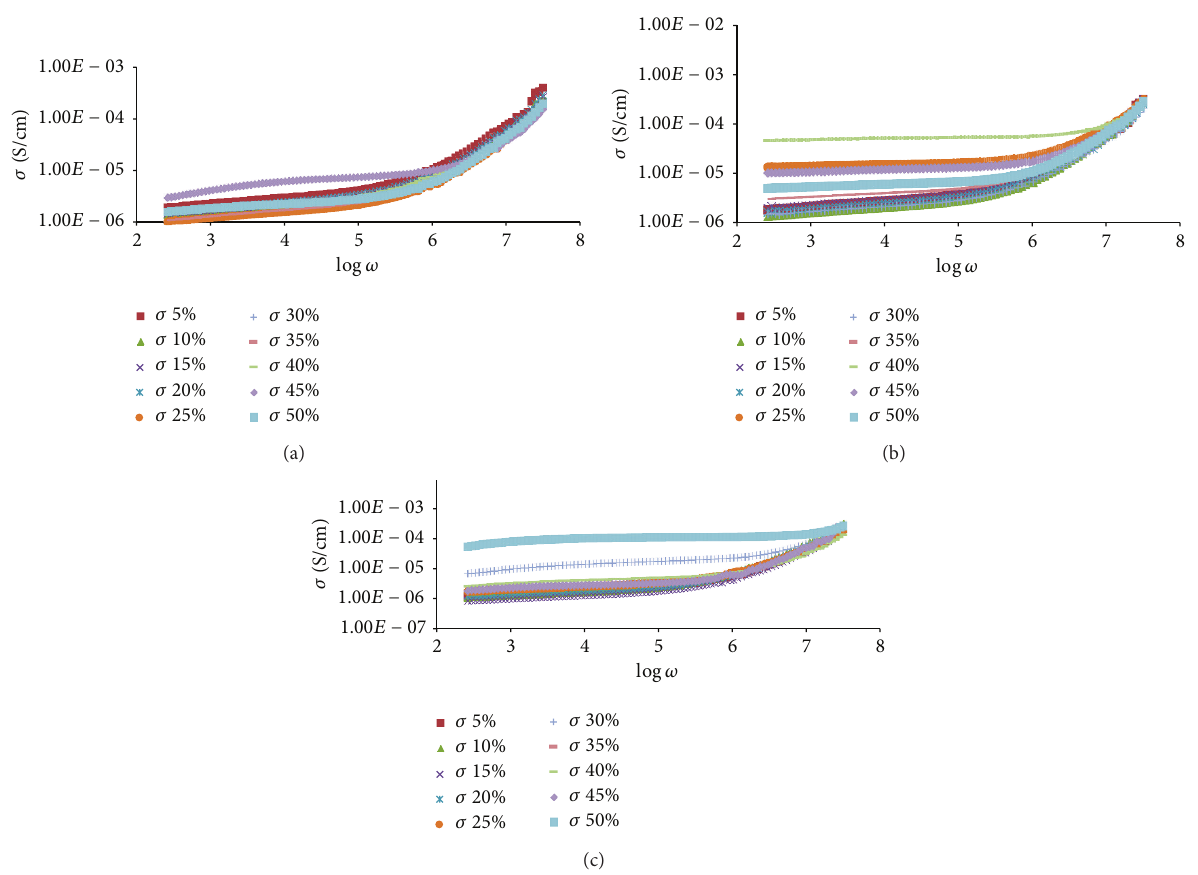
Figure 3: Conductivity variations with frequency for different system (a) NaClO 4 Salt, (b) NaI salt, and (c) NaSCN